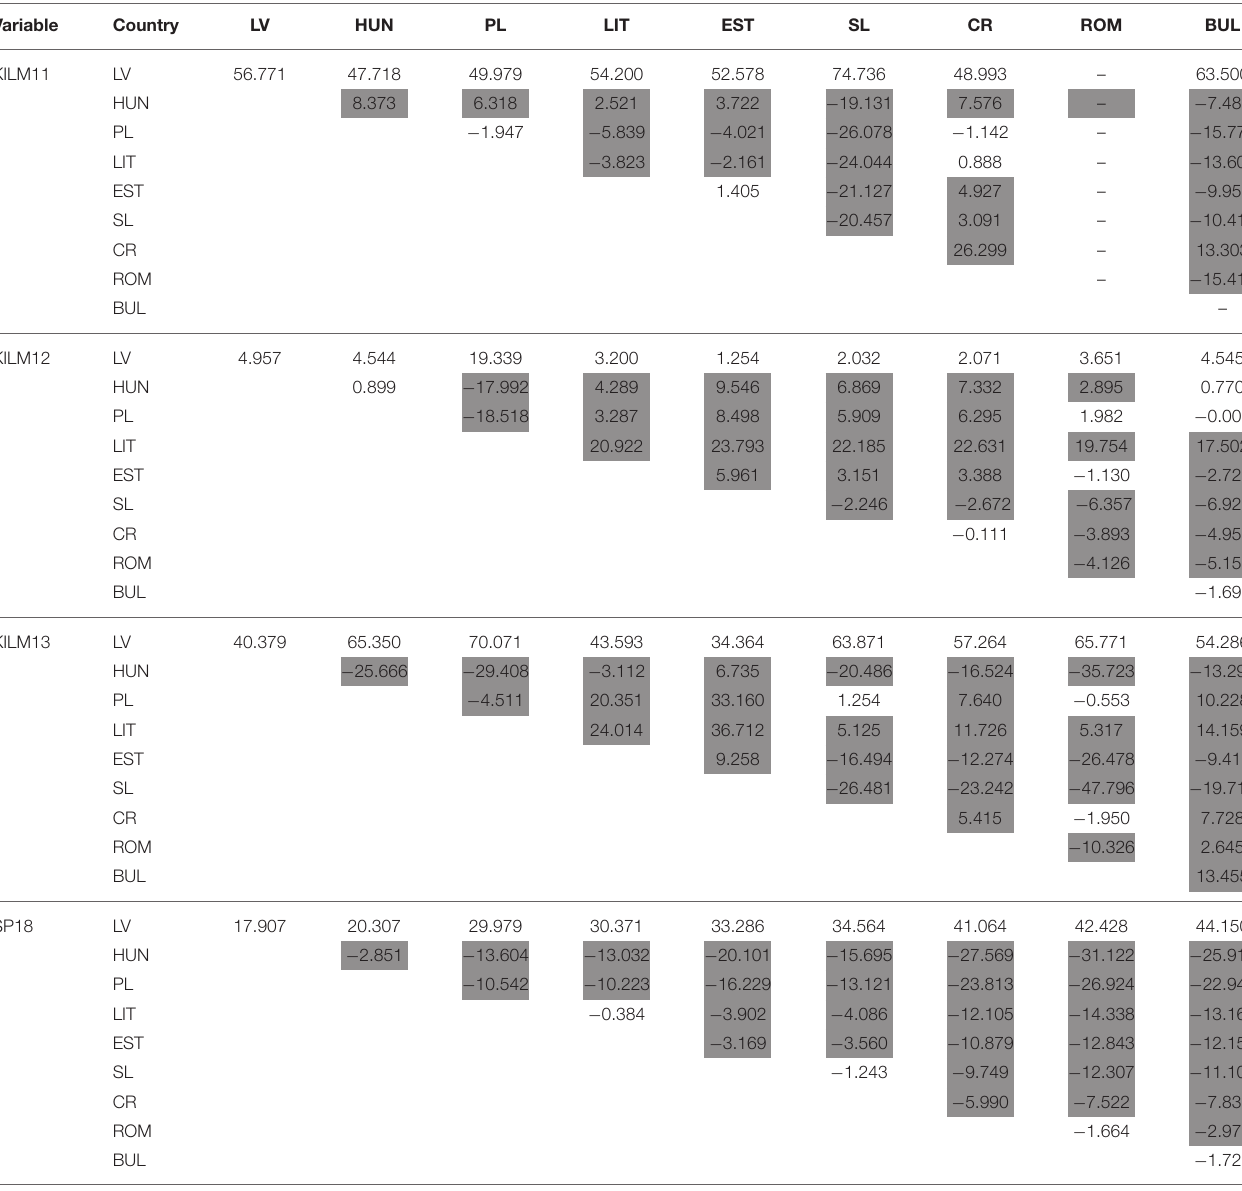
TABLE 9 | Test for significance of mean differences for women (statistically significant differences market as gray areas). Variable Country KILM11